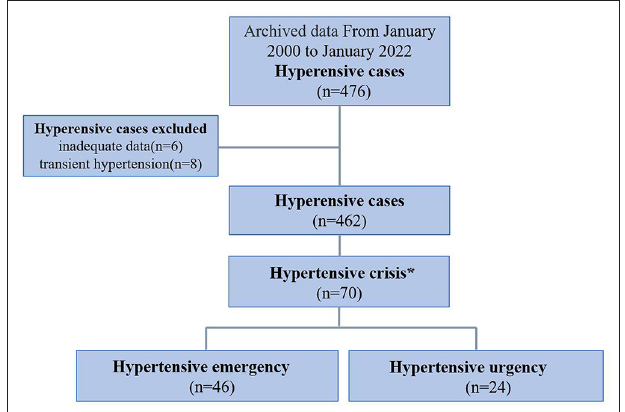
FIGURE 1 | Flow chart showing the process of patient selection. A total of 476 children were diagnosed with hypertension from January 2000 to January 2022. Excluding 6 patients with incomplete data and 8 patients with transient hypertension, 462 patients met the inclusion criteria. Among them, 70 patients met the criteria of hypertensive crisis and were then divided into hypertensive emergency group (with acute or ongoing target organ lesions) and hypertensive urgency group (without evidence of target organ lesions). *Hypertensive crisis was defined as BP ≥ 99th percentile + 5 mmHg.